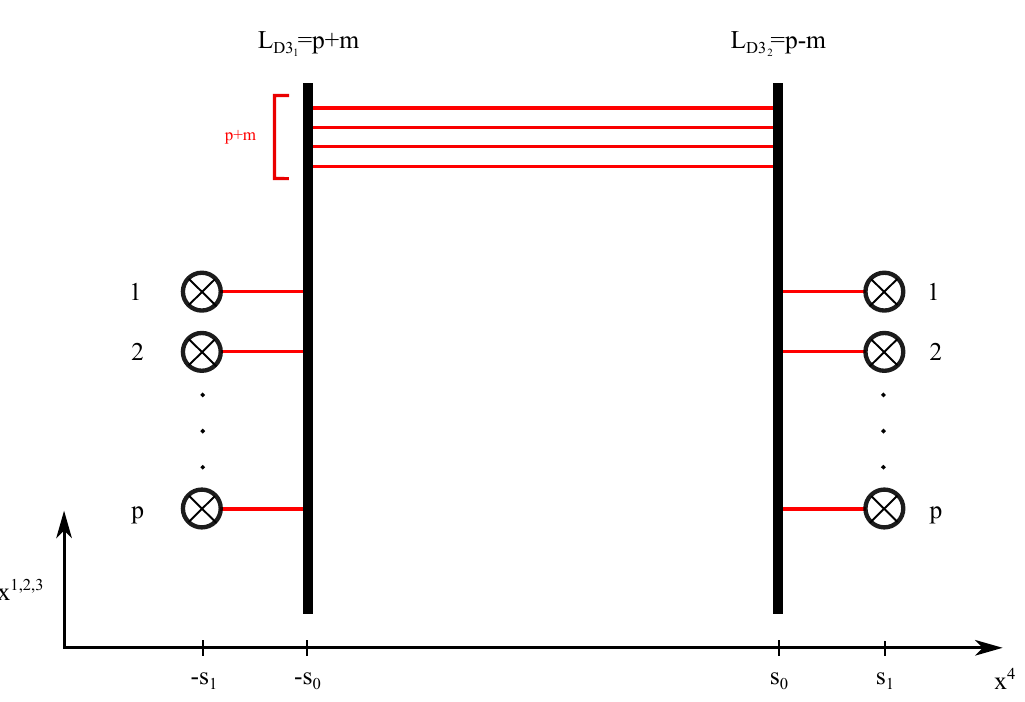
Figure 8 . D1-D3-NS5 brane con(cid:12)guration for singular monopoles in an SU(2) theory. Circles with crosses, horizontal lines in red, and vertical black lines, denote NS5-branes, D1-branes and D3-branes respectively. Linking numbers of the two D3 branes are m + p and (cid:0) m + p respectively, while the NS5 linking numbers are all equal to 1, as described